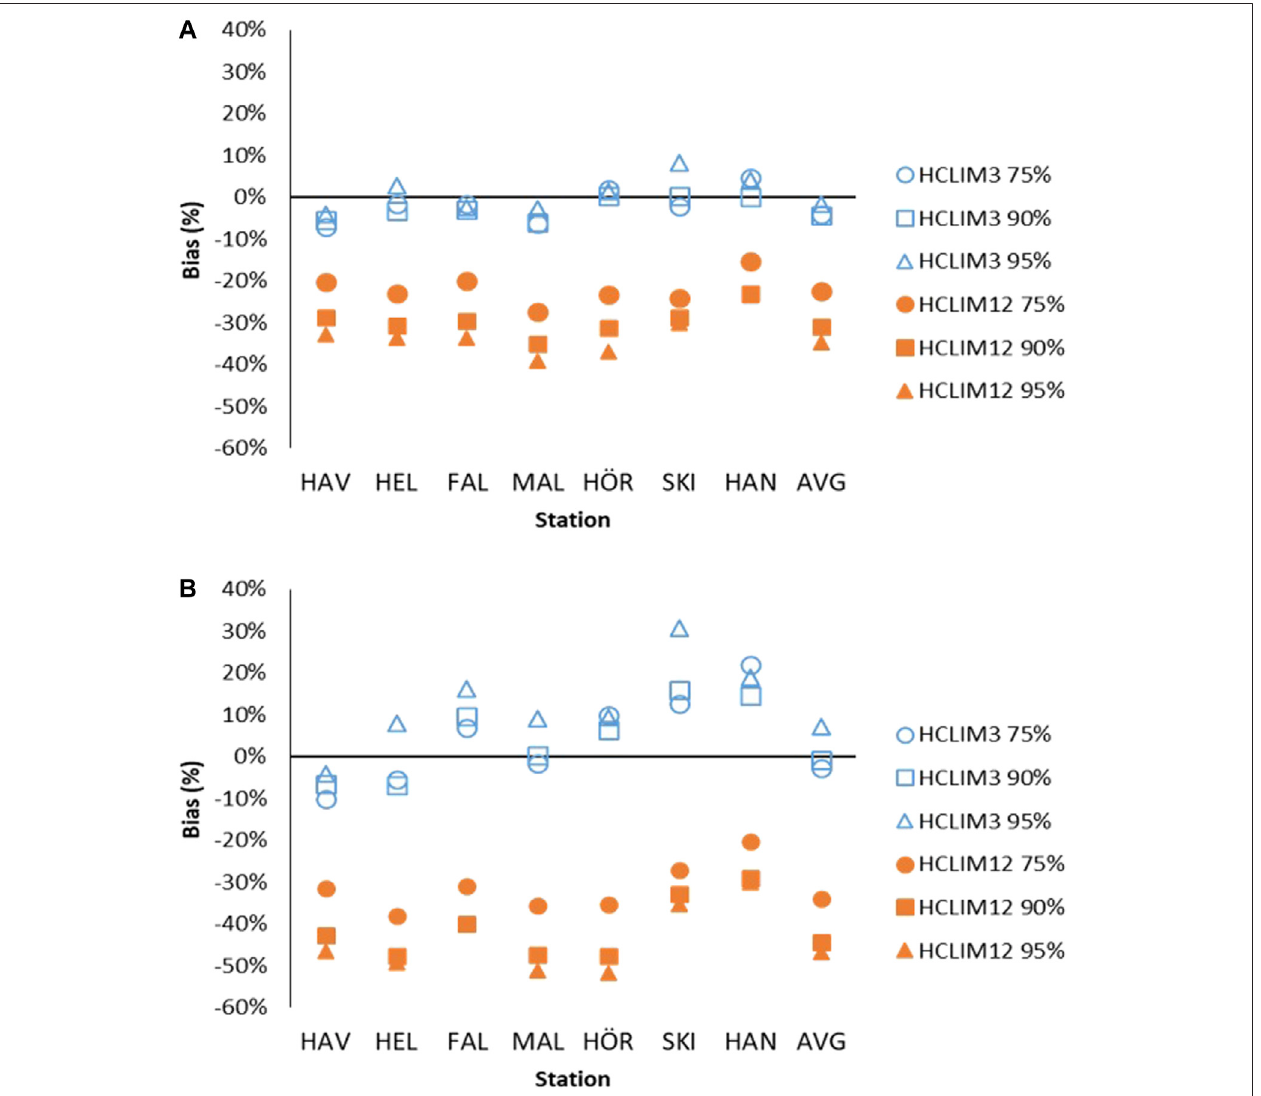
FIGURE 5 | Bias of 1-h rainfall percentiles I 75 wet , I 90 wet and I 95 wet in HCLIM3 and HCLIM12 for annual averages (A) and summer (Jun-Aug) averages (B) . Circle, square and triangle represent percentile 70, 90, and 95, respectively.